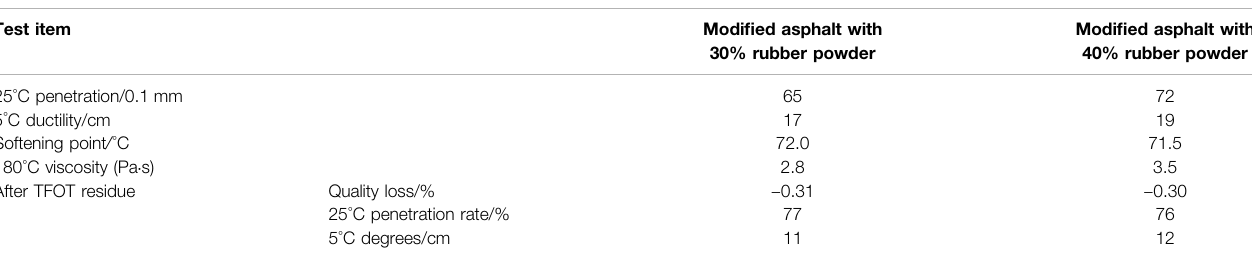
TABLE 1 | Performance index of rubber powder modi fi ed asphalt. Test item